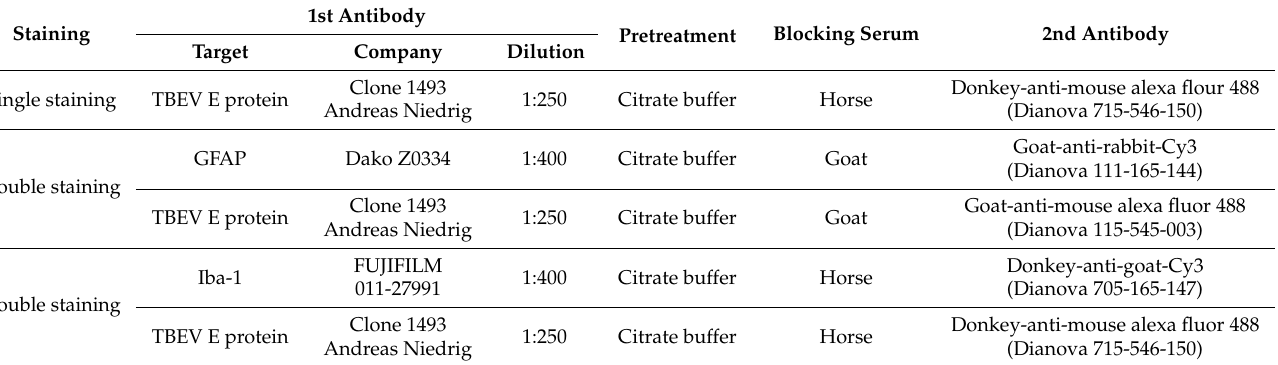
Table 1. Antibodies and reagents of